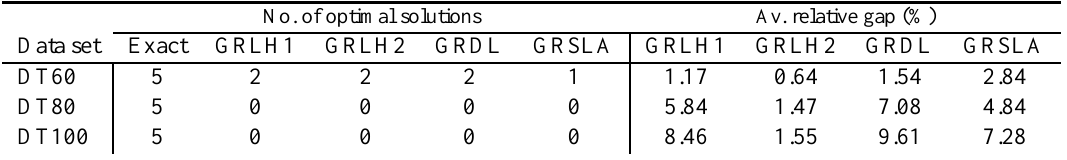
Table 12. Summary of results for small